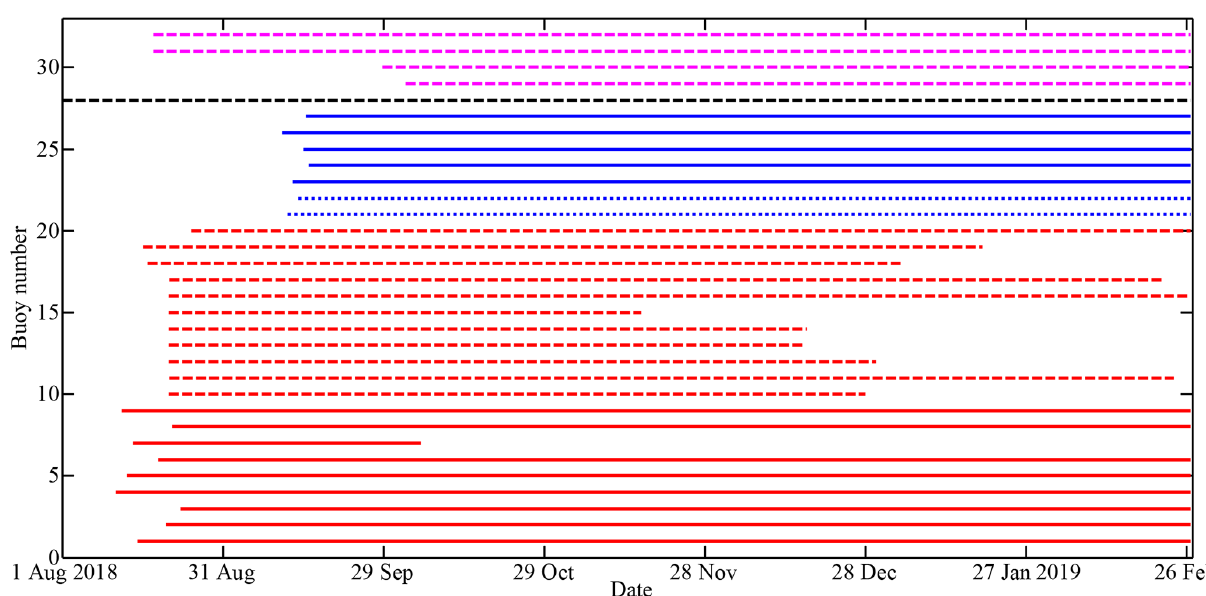
Figure 1. Operational periods of all buoys included in this study. Red lines denote buoys deployed during CHINARE in August 2018; blue lines denote buoys deployed during TICE; the black line indicates the buoy deployed during CHINARE 2016; purple lines represent IABP buoys. Solid, dashed, short-dashed, and dotted–dashed lines denote SIMBA, TUT, SB, and iSVP or other buoys, respectively.